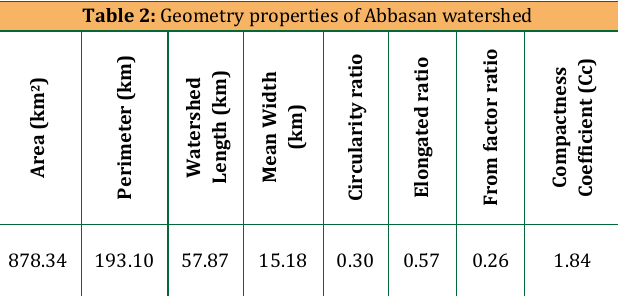
Table 2: Geometry properties of Abbasan